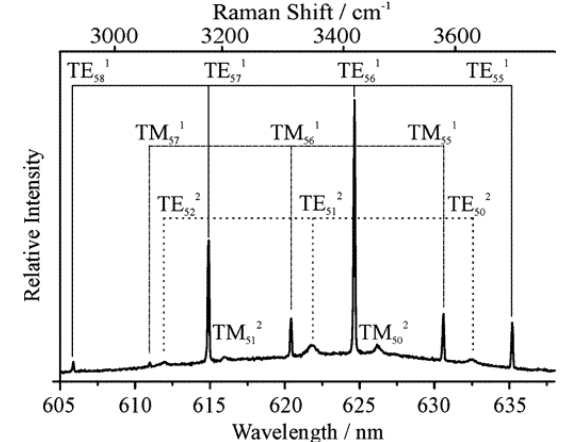
Figure 17. Schematic diagram of the dual trap configuration of the optical tweezers. Reprint with permission by Butler et al. (2008). Copyright 2008 Royal Society of Chemistry.